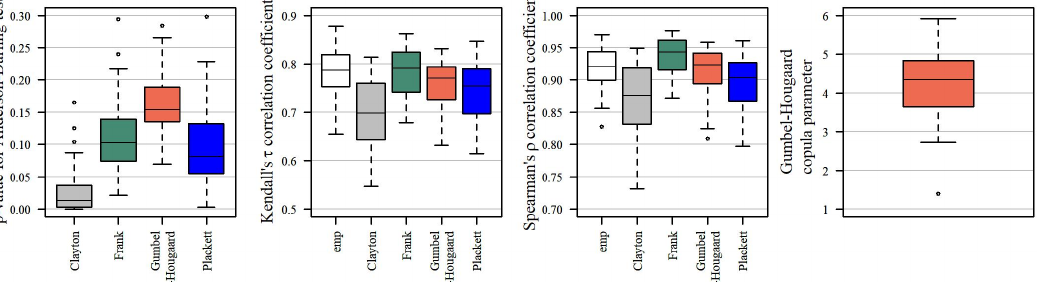
Figure 12. p v -values of of the bivariate Anderson–Darling goodness-of-fit test, Kendall and Spearman correlation coefficients of the variables T g max and V g max : empirical and computed for the probability distribution by using copulas (Clayton, Frank, Gumbel–Hougaard and Plackett), and Gumbel– (cid:16) (cid:17) T g max , V g max Hougaard copula parameter used to estimate the joint distribution of . The lower and upper borders of the box are the first and third quartiles and the line inside the box—the median value. The whiskers extend to 1.5 × the interquartile range. The points outside the whiskers represent statistical outliers.